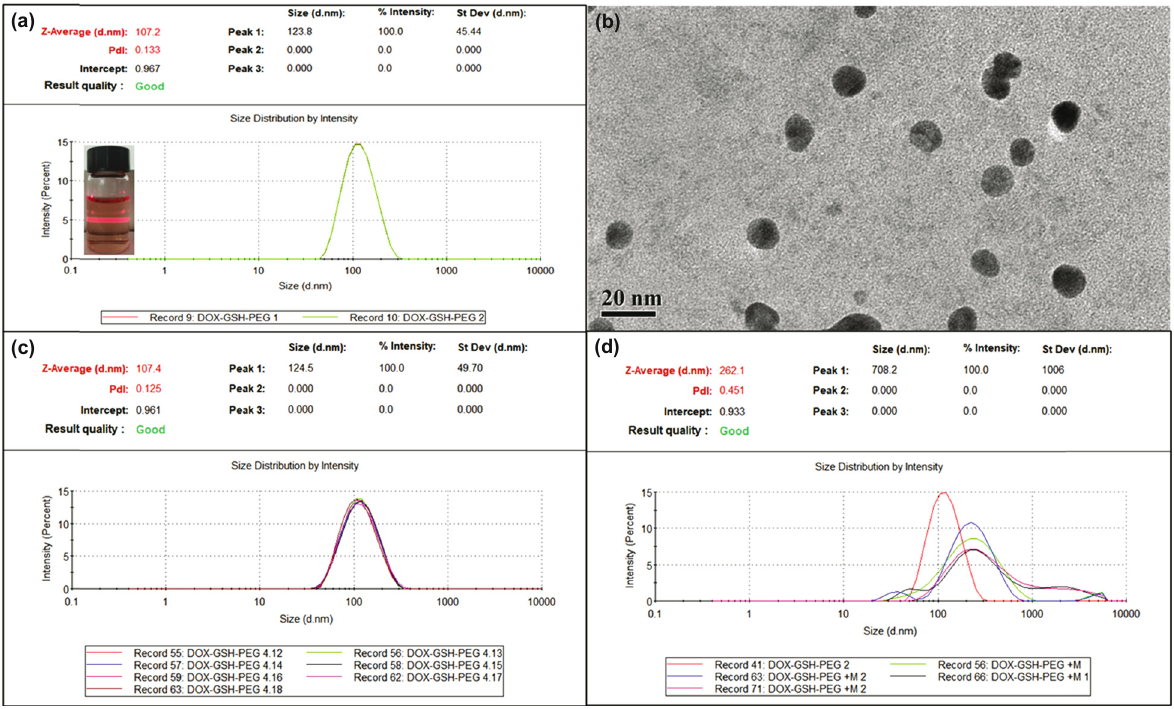
Figure 2: The particle size of DOX - GSH - PEG micelle measured by ( a ) DLS and ( b ) TEM; ( c ) the stability of DOX - GSH - PEG micelle in PBS during 1 week and ( d ) the esterase - responsive un - stability of DOX - GSH - PEG micelle in esterase environment.